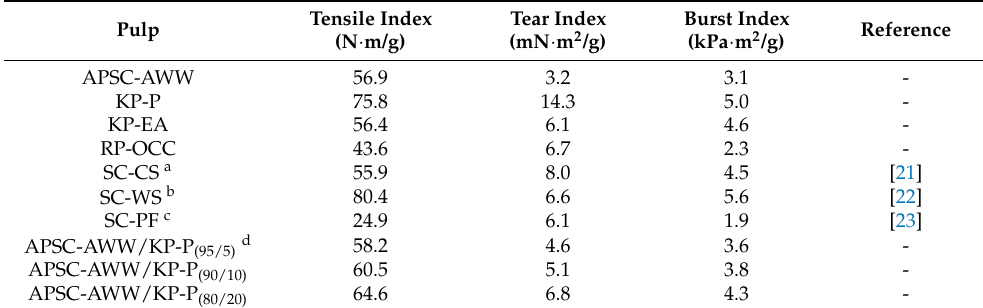
Table 2. Comparison of physical properties of paper sheets from different